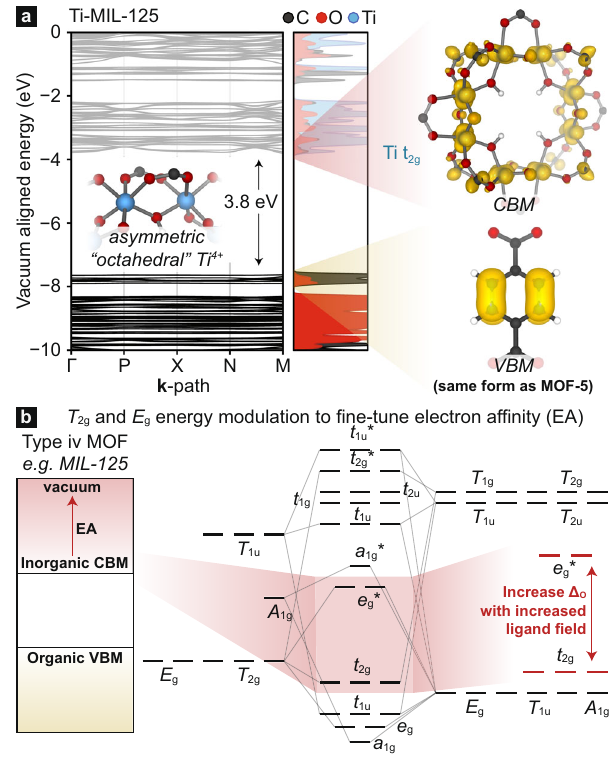
Fig. 1 The electronic structure of Ti-MIL-125. Ti-MIL-125 features pseudo- octahedral Ti 4 + ions. In complex MOF clusters, such as that of MIL-125, a the valence band may have organic π -antibonding character, whereas the conduction band is delocalized around the Ti-octamer. b In the octahedral con fi guration the sigma manifold affects the energy of the e g * and the ligand LUMOs control the stability of the metal t 2g orbitals. The Ti-orbitals have d xy/xz/yz character, and hence should be affected by the π -manifold of the